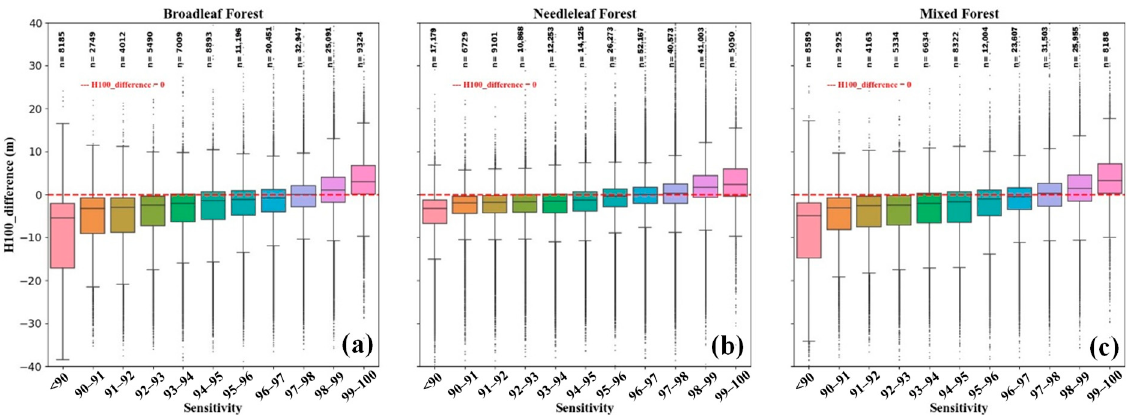
Figure 5. H100_difference (GEDI H100 − ALS Hmax) versus sensitivity for ( a ) broadleaf, ( b ) needleleaf, and ( c ) mixed forests. In addition, the number of GEDI shots ( n ) is displayed for each sensitivity range.